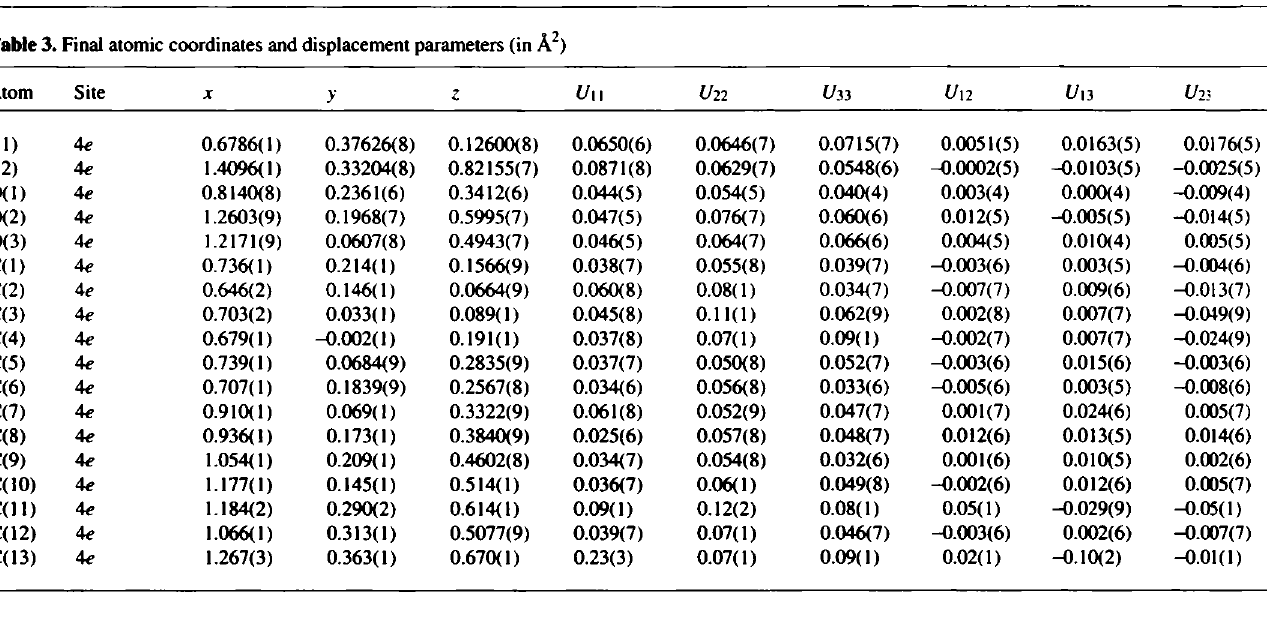
Table 3. Final atomic coordinates and displacement parameters (in